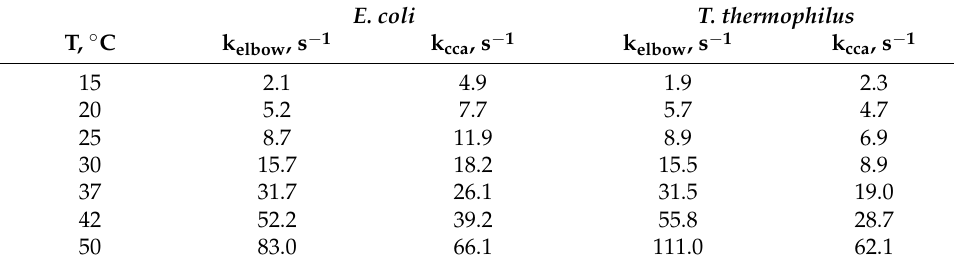
Rate constants determined at 5 µ M EF-G; Standard error of the mean did not exceed ± 5%; k elbow —rate constant of translocation detected by the label at the elbow region of tRNA; k cca —rate constant of translocation detected by the label at CCA-end of